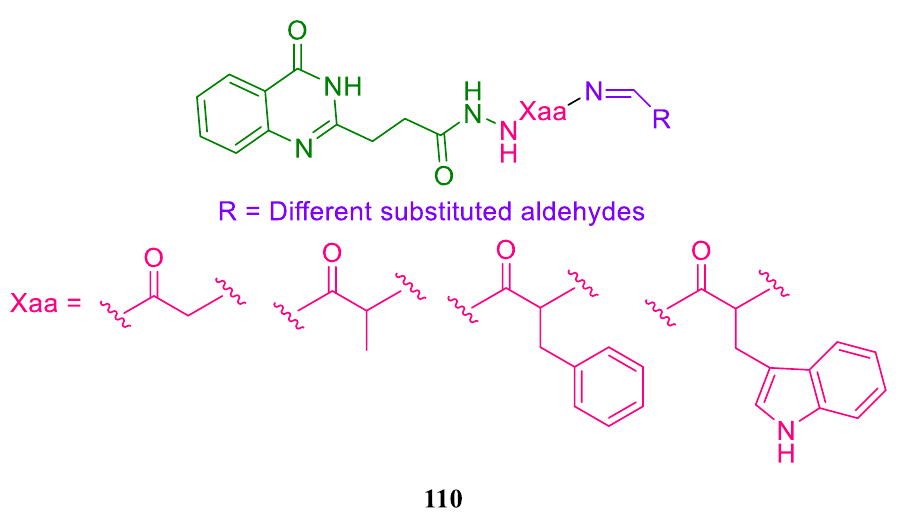
Figure 89. Amino acids conjugated to quinazolinone-Schiff bases.